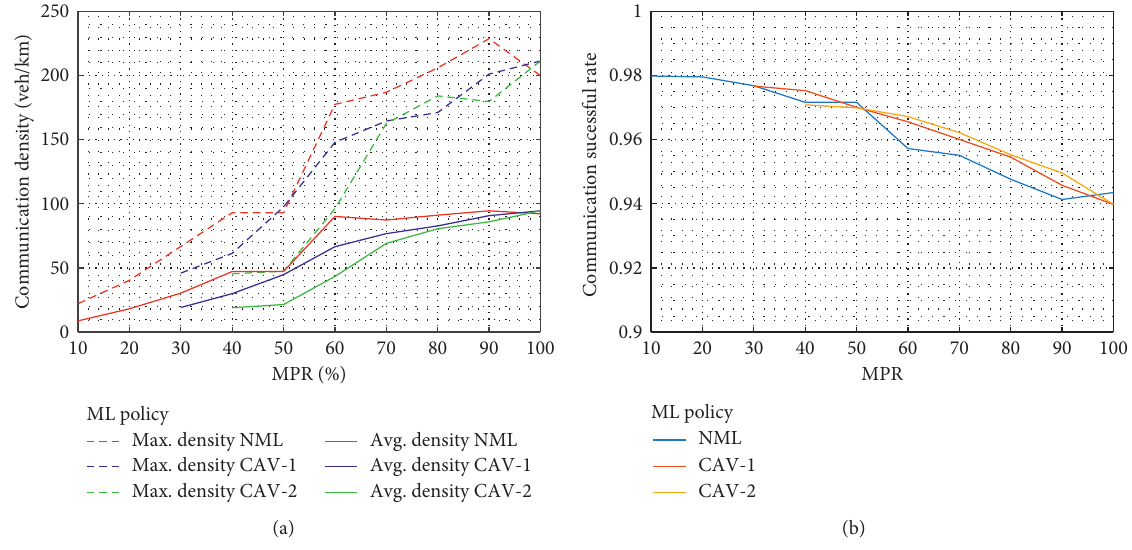
Figure 11: V2V communication performance measure. (a) Vehicle density. (b) Packet perception rate.